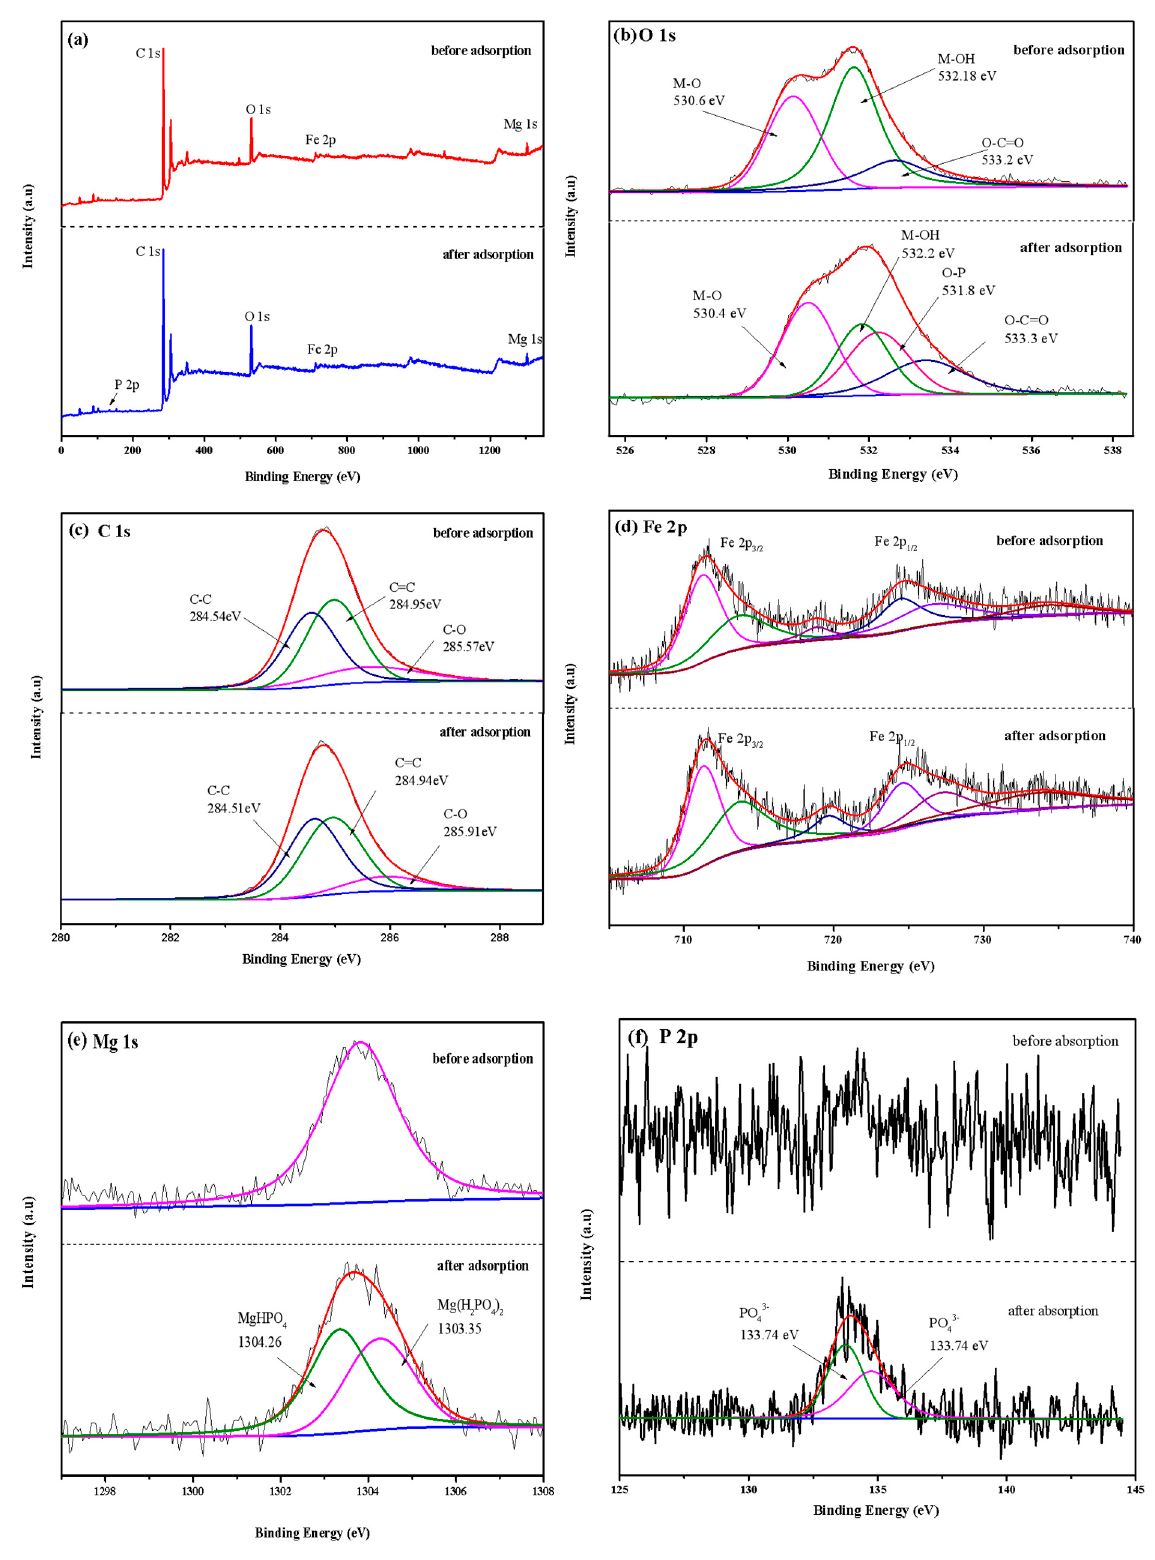
Figure 11. XPS survey spectra ( a ), O 1s ( b ), C 1s ( c ), Fe 2p ( d ), Mg 1s ( e ), and P 2p ( f ). In order to further investigate the release of P by the phosphate-adsorbed LDHs-BC4, P release amount of the phosphate-adsorbed LDHs-BC4 was measured in the successive 7 days and the results are shown in Figure 13. Except for the highest P release (1.713